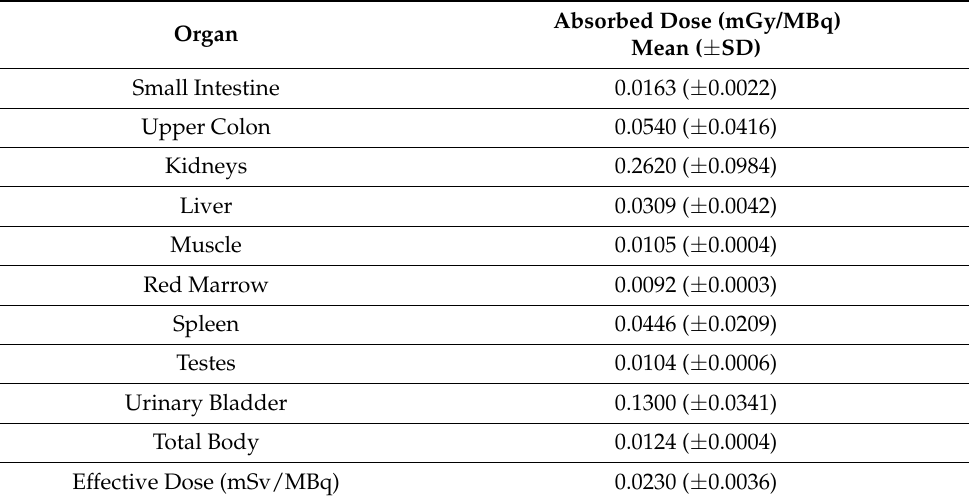
Table 2. Absorbed organ doses of [ 68 Ga]Ga-PSMA-11 in selected organs [53].